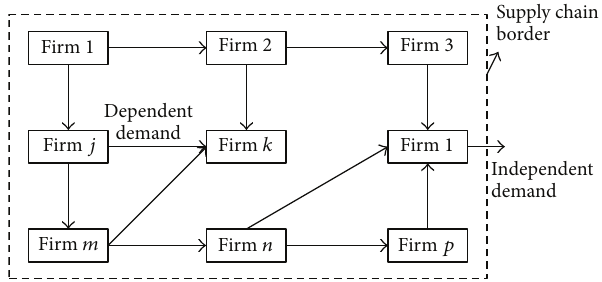
Figure 1: Schematic map of complex supply